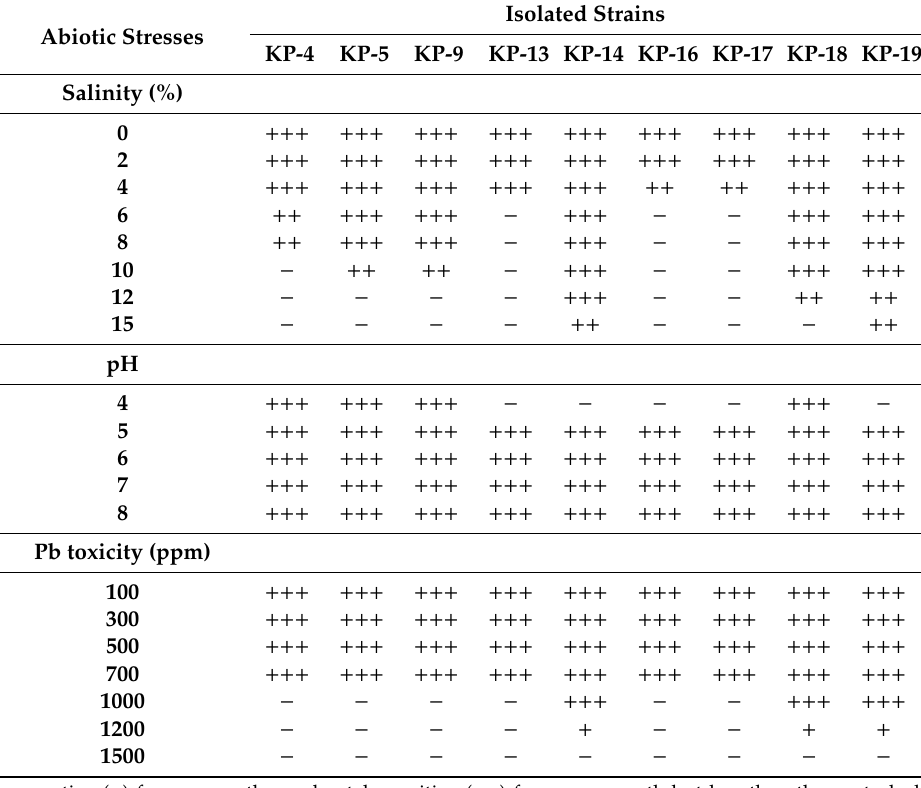
Table 4. Plant growth-promoting characteristics exhibited by selected isolates: KP-14, KP-18, and KP19.